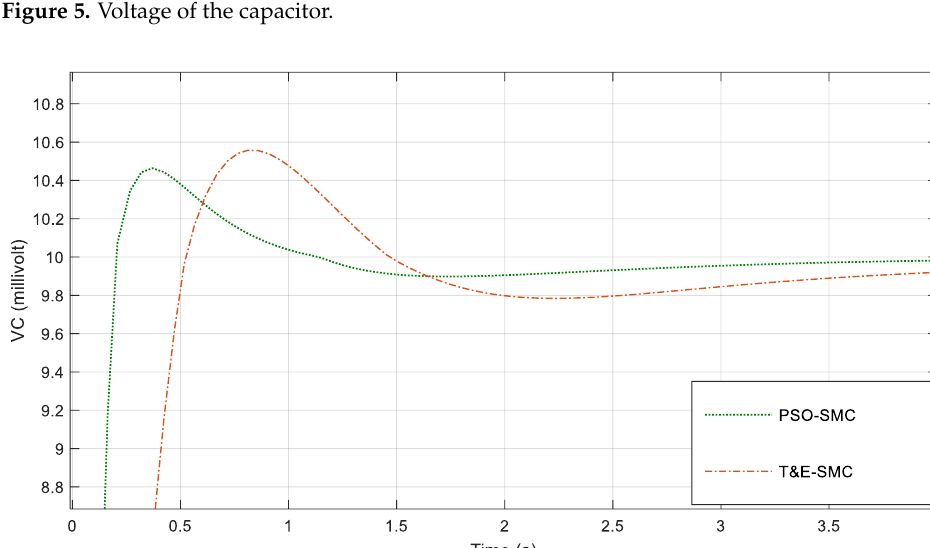
Figure 6. Magnification of Figure 5 around the first second.